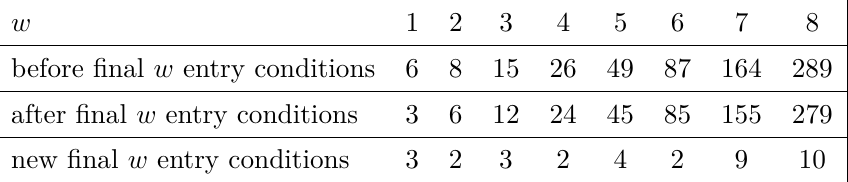
Table 5. Dimension of the space of potential { 2 L − w, 1 , . . . , 1 } w th coproduct entries of the L -loop form factor, before and after imposing the w -final-entry conditions. We also give their difference, which is the number of non-trivial, new constraints at weight w (not accounting for dihedral